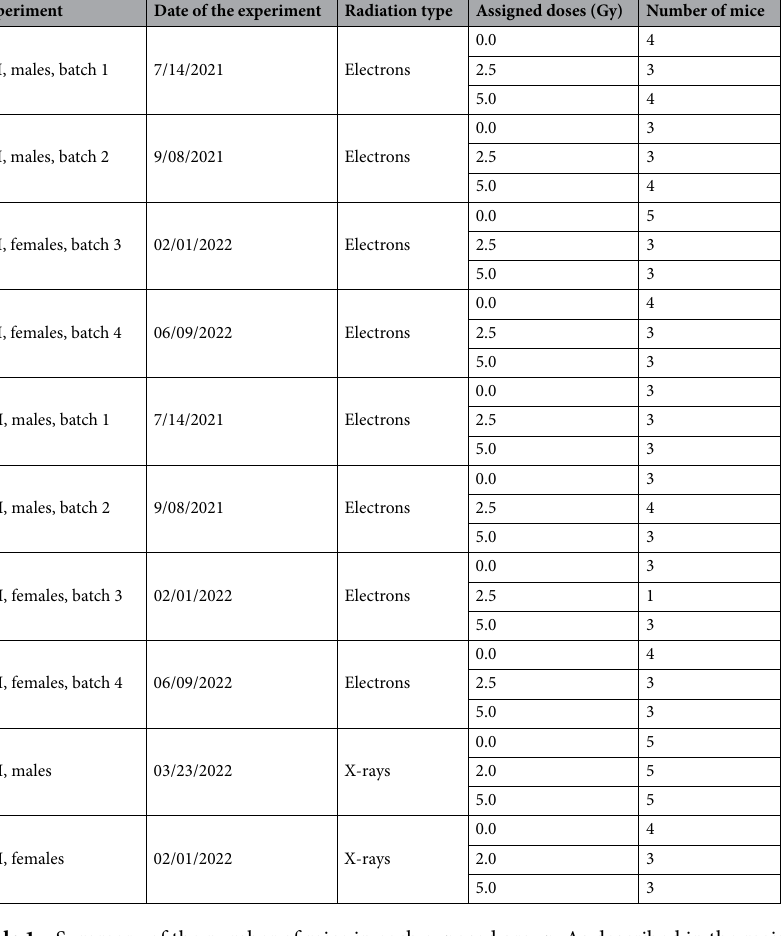
Table 1. Summary of the number of mice in each exposed group. As described in the main text, detailed dosimetry was performed on each mouse and dose variations around the nominally assigned values were accounted for in the analysis, and two mouse samples in the TBI females batch 3 group were excluded from analysis due to insufficient number of B and T cells for scoring. In total, 42 mice were assigned to PBI (16 of them sham-exposed) and 36 mice to TBI exposures (13 of them sham-exposed) using CLINAC electrons, and 25 mice were assigned to x-ray exposures (9 of them